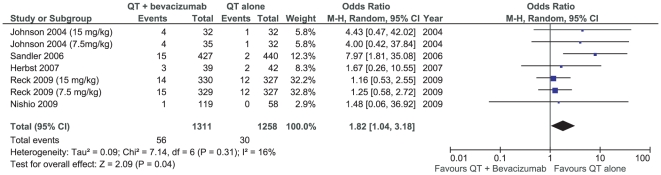
Meta-analysis of deaths related to treatment.